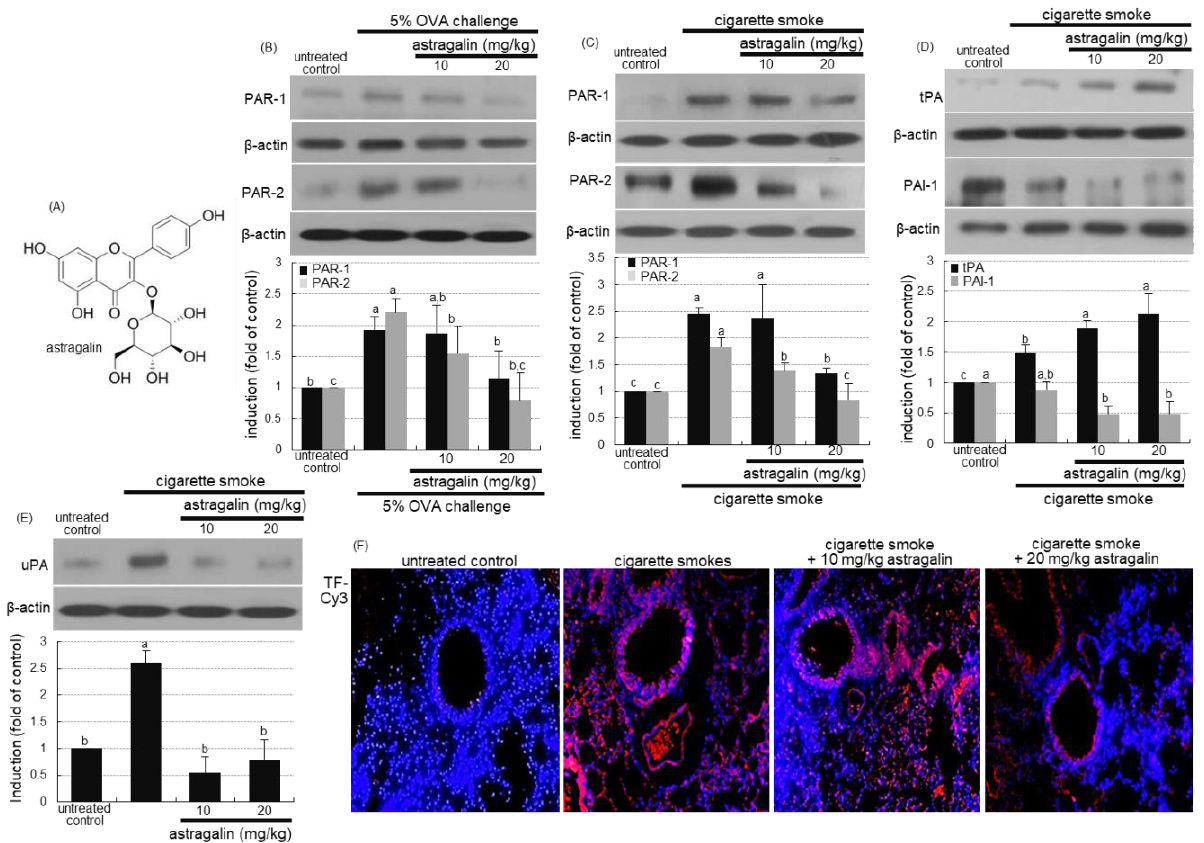
Figure 1. Chemical structure ( A ) and inhibition of induction of protease-activated receptor (PAR) proteins ( B , C ) and plasminogen activator proteins (tPA and uPA) and plasminogen activator inhibitor-1(PAI-1, ( D , E )) by astragalin in lung tissues of ovalbumin (OVA)- or cigarette smoke-exposed mice. Mice were orally administrated with 10 or 20 mg/kg astragalin and exposed to cigarette smoke. Additionally, BALB/c mice were OVA-sensitized and orally supplemented with 10–20 mg/kg astragalin ( B ). Tissue extracts were subject to Western blot with a primary antibody against PAR-1, PAR-2, tPA, PAI-1 or uPA ( B – E ). β -Actin protein was used as an internal control. The bar graphs (mean ± SEM, n = 3) represent quantitative results of the upper bands obtained from a densitometer. Values in bar graphs (same achromatic colored) not sharing the same lower case alphabet letter indicate a significant difference at p < 0.05. The tissue factor (TF) localization was identified as Cy3-red staining in mouse lungs exposed to cigarette smoke ( F ). Nuclear staining was done with 4 ′ ,6-diamidino-2-phenylindole (blue). Each photograph is representative of four mice. Magnification: 200-fold.